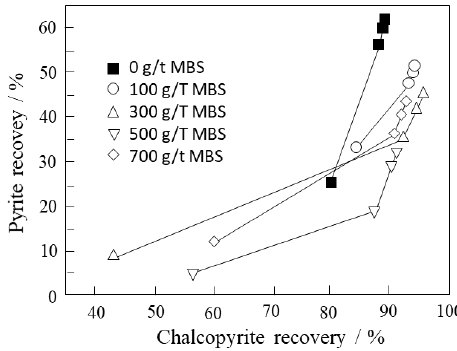
Figure 36. Recovery of pyrite versus chalcopyrite using seawater at pH 8.5. Metabisulfite was added to the mill before grinding. Tests were carried out with artificial seawater and modified thionocarbamate as a collector and MIBC as a frother (adapted from Mu et al. [74]).